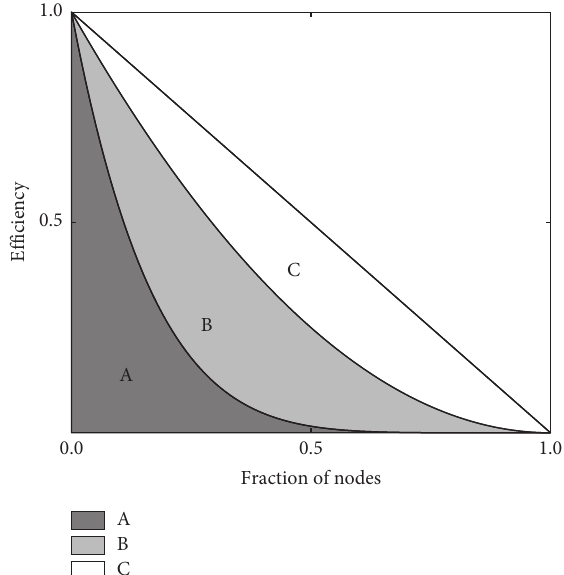
Figure 7: The diagram for calculating the modified Gini coefficient.